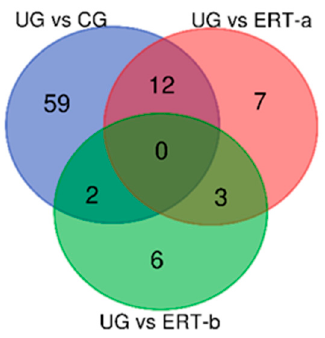
Figure 7. Venn diagram showing the distribution of leukocyte proteins that were the healthy control. Abbreviations: CG, control group; UG, untreated group; ERT-a, patients sampled before enzyme infusion; ERT-b, patients sampled 24 h after enzyme infusion.